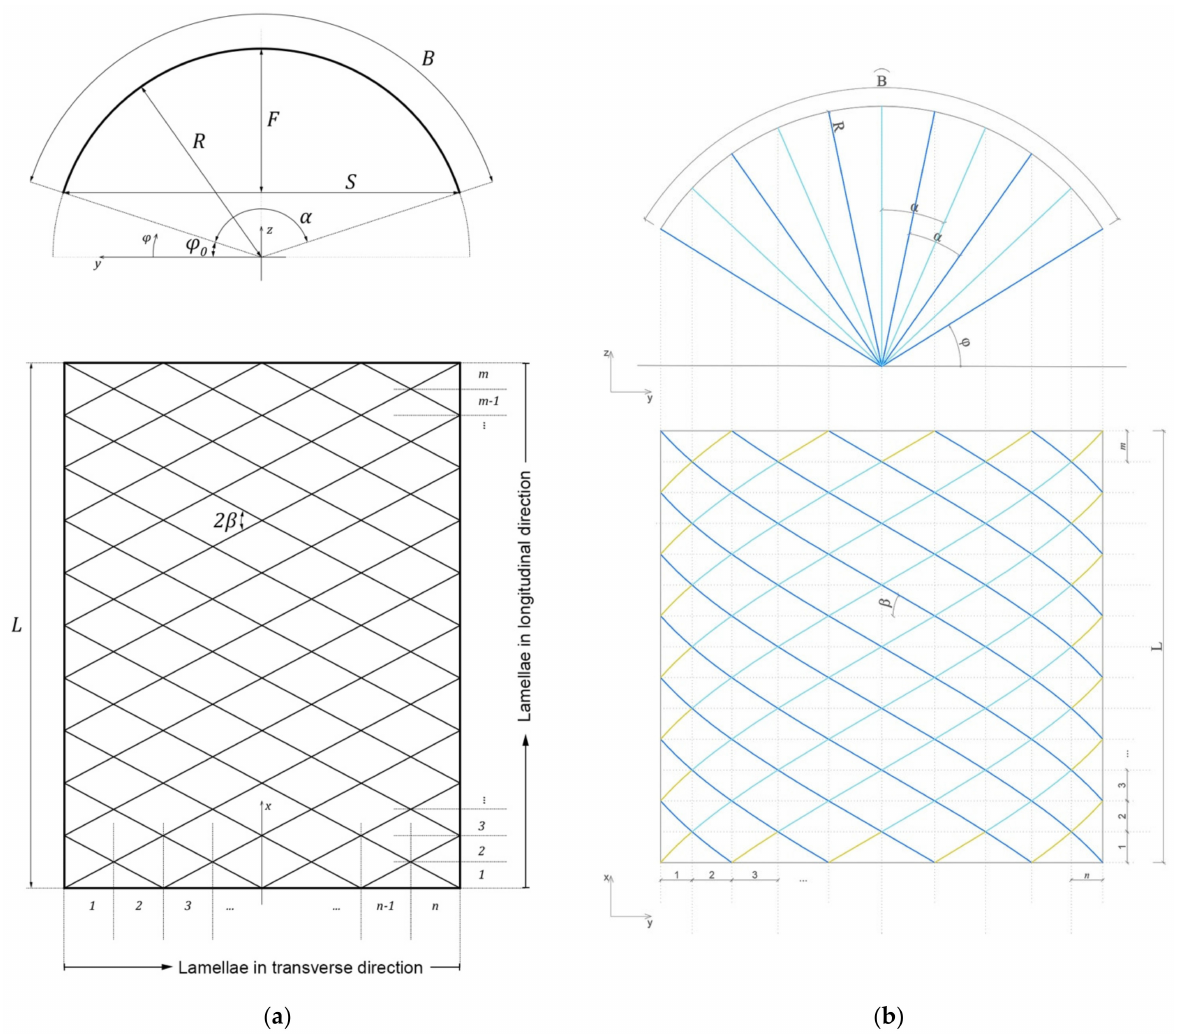
Figure 8. Floor plan and section of the lamella vault for geometrical analysis ( a ) by Tutsch [13]; ( b ) by the